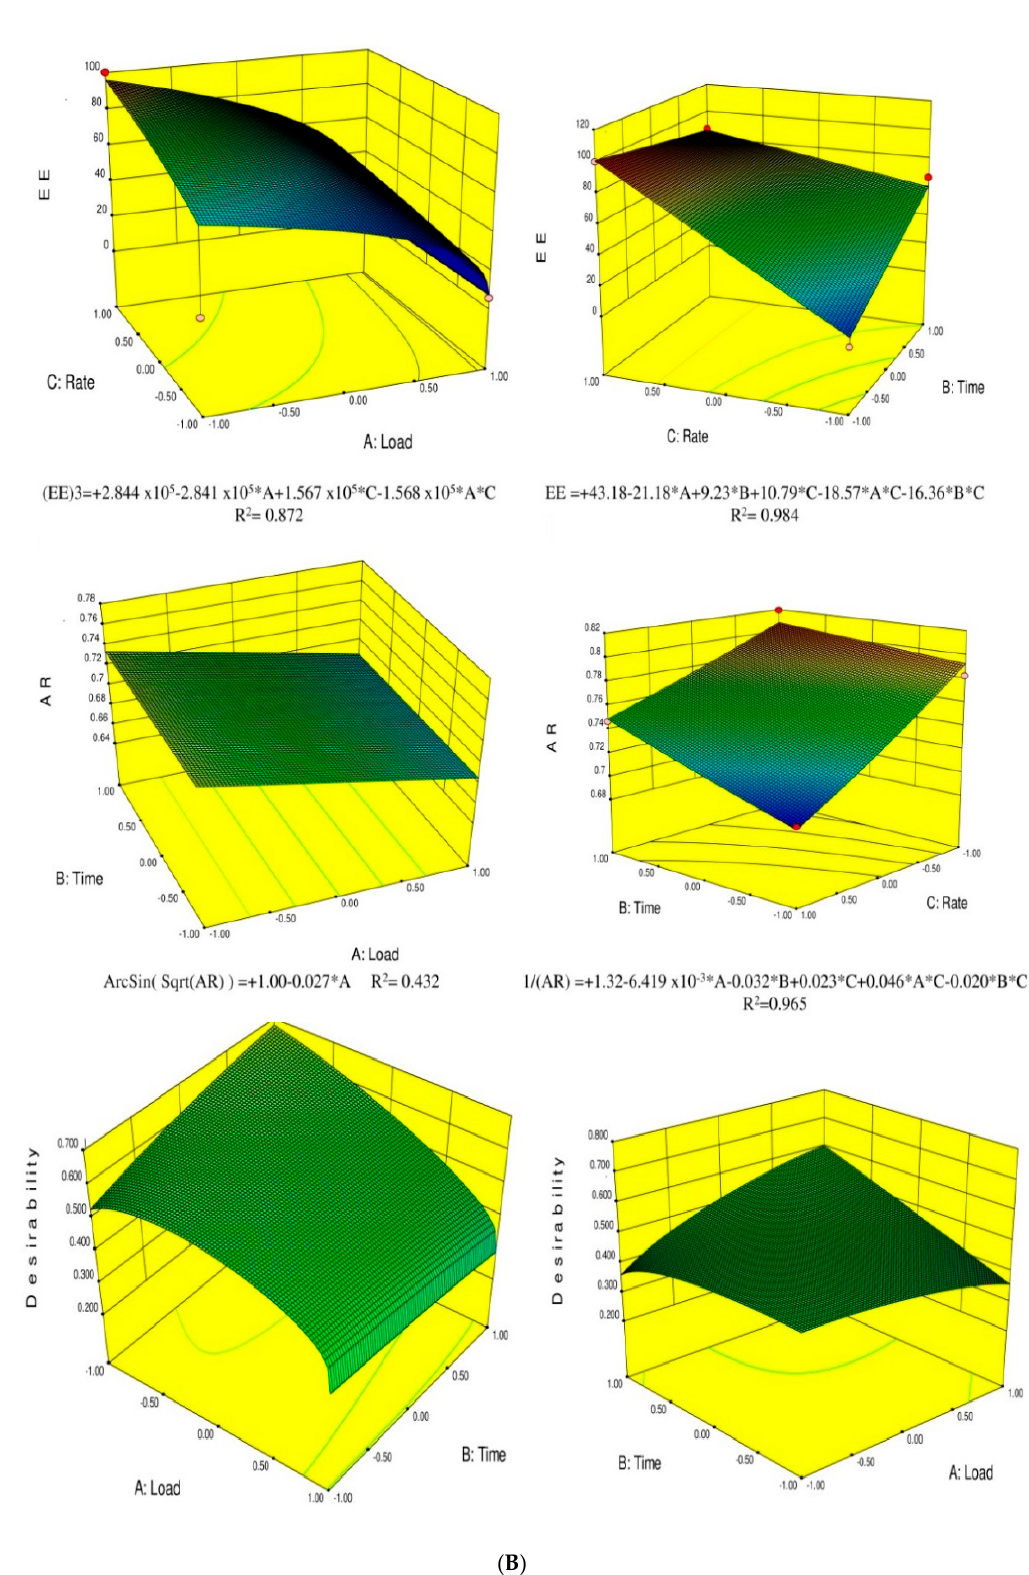
Figure 2. ( A ) Response surface graphics for preparation methods in cold ( Left ) and hot ( Right ) for the parameters: polydispersity index (PDI), Particle size (PS) and zeta potential (ZP); ( B ) Response surface graphics for preparation methods in cold ( Left ) and hot ( Right ) for the parameters: encapsulation efficiency (EE), aspect ratio (AR) and desirability.